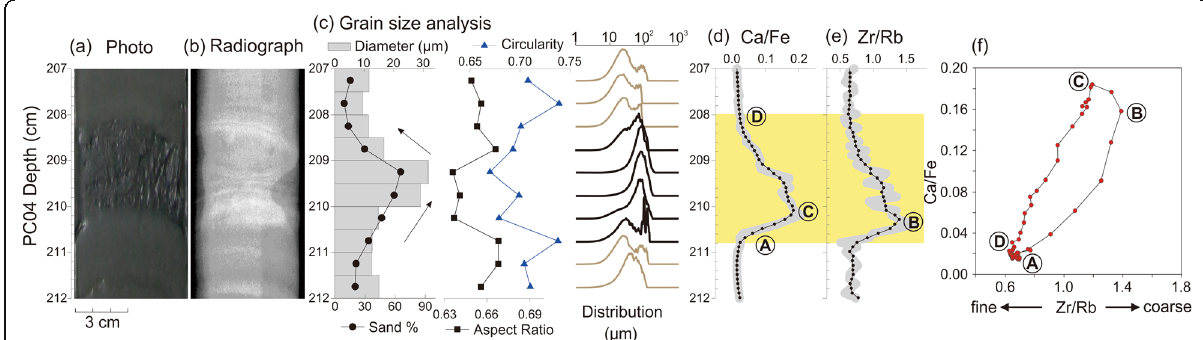
Fig. 8 Detailed analytical results for turbidite T25 (207.0 – 212.0 cm depth in PC04): a photograph, b X-ray fluorescence image, c grain size analysis (mean grain diameter, percentage sand, and grain size distribution) of 0.5 cm-thick samples, d Ca/Fe ratios, e Zr/Rb ratios, and f Ca/Fe vs. Zr/Rb. Raw data (thick gray line curve) and 5-point running averages (black dots) are shown in d and e . Upward-coarsening then upward-fining trends from A to D in T25 show good correlation with the Ca/Fe and Zr/Rb variations. The highest Ca/Fe (C) and Zr/Rb values (B) are slightly offset, which can be observed as a loop in ( f